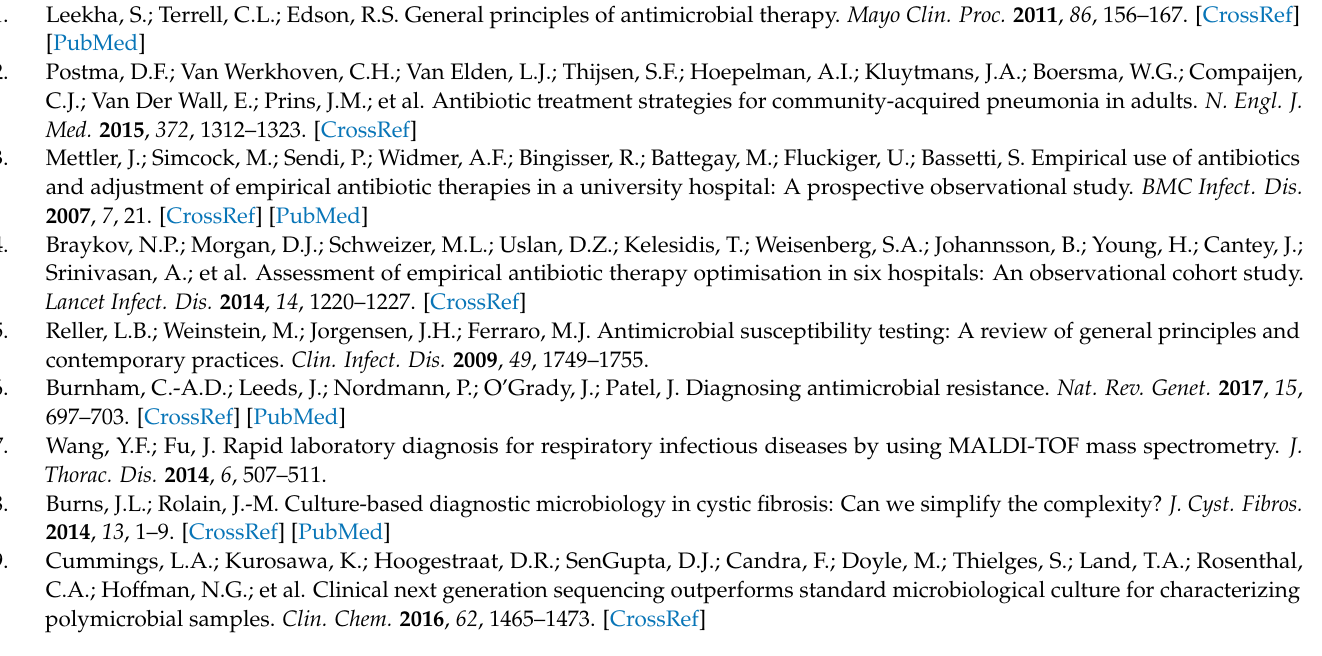
antibiotics. Supplementary Table S2. Results of antimicrobial susceptibility testing by using the AtbFinder system (4 h culturing) and standard method (24 h culturing) for 119 Gram-positive and Gram-negative pathogens. Supplementary Table S3. Results of antimicrobial susceptibility testing by using the AtbFinder system and standard method for 122 Gram-positive and Gram-negative pathogens after 24 h of